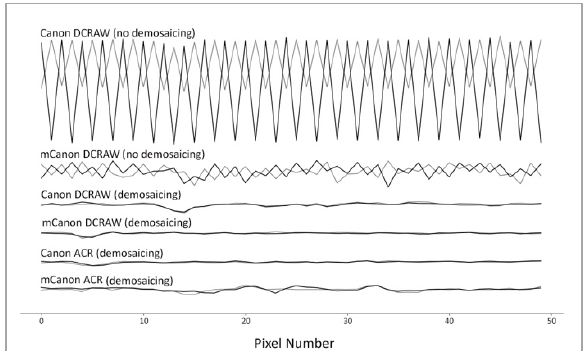
Figure 3. RAW processing and pixel pattern. Vertical profiles of pixel intensities measured from a white patch from unmodified (‘Canon’) and modified (‘mCanon’) camera images with different processing with two rows of 50 pixels compared. The top profile shows what a CFA would look like without demosaicing and the second profile shows the fixed pattern noise in the mCanon images processed without demosaicing. After the flat field correction, the TIFF images are scaled using a black and white point. For the FADGI target the black and white patches are used to map to the 4% output for the blacks and 97% output for the whites. The scaling maintains linearity; however, displays are nonlinear so a gamma correction needs to be applied for visualisation. A gamma correction of approximately